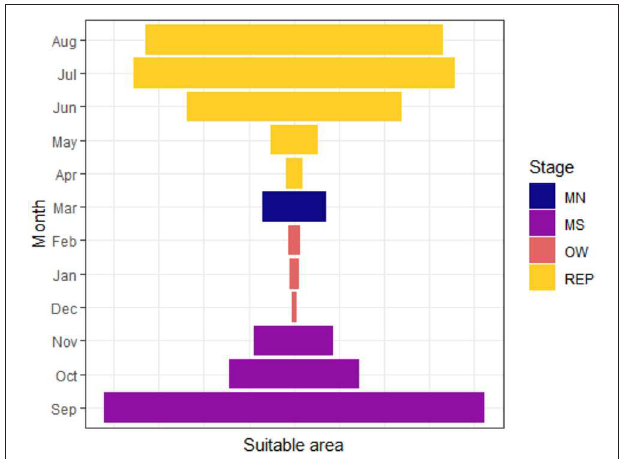
FIGURE 4 | Expansion-contraction pattern of the suitable area extent for month and seasons for the monarch butterfly migratory route. MN, northward movement; MS, southward movement; OW, overwintering; REP, reproduction.